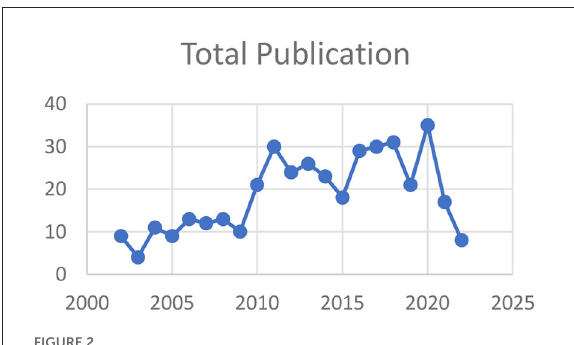
FIGURE2 Total publications on spatio-temporal product-sum